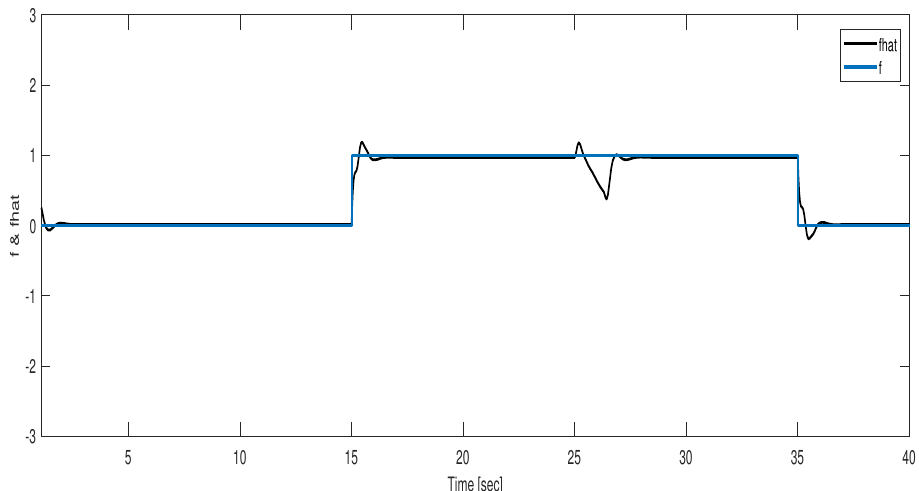
Figure 4. Illustration of robust sensor fault reconstruction (rotor speed sensor fault).